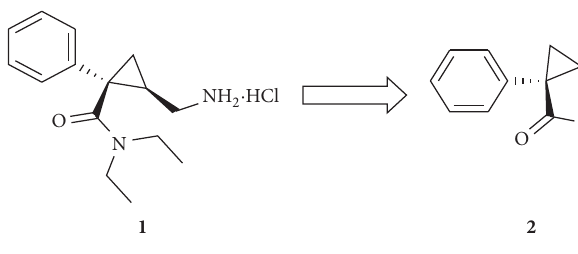
Scheme 4: Retrosynthesis of milnacipran.